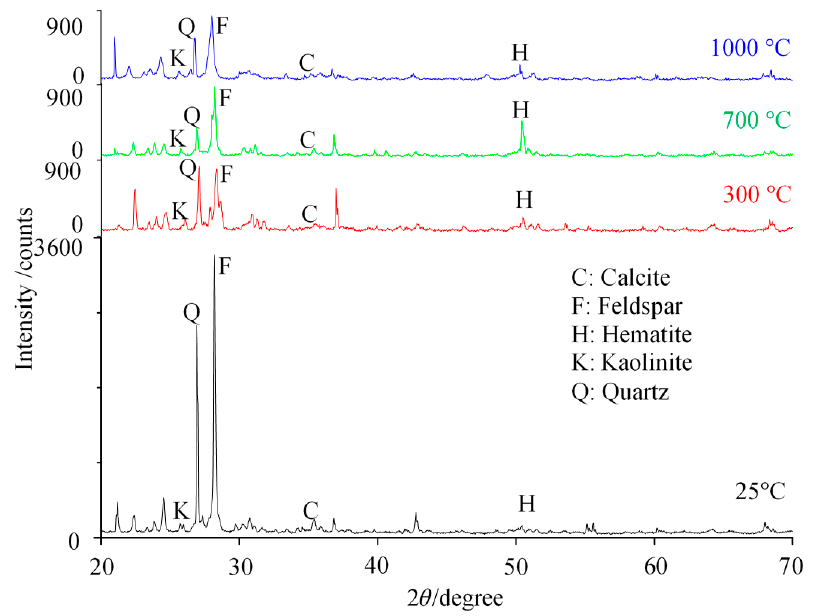
Figure 19. XRD spectra for the powder of sandstone after different thermal treatments.